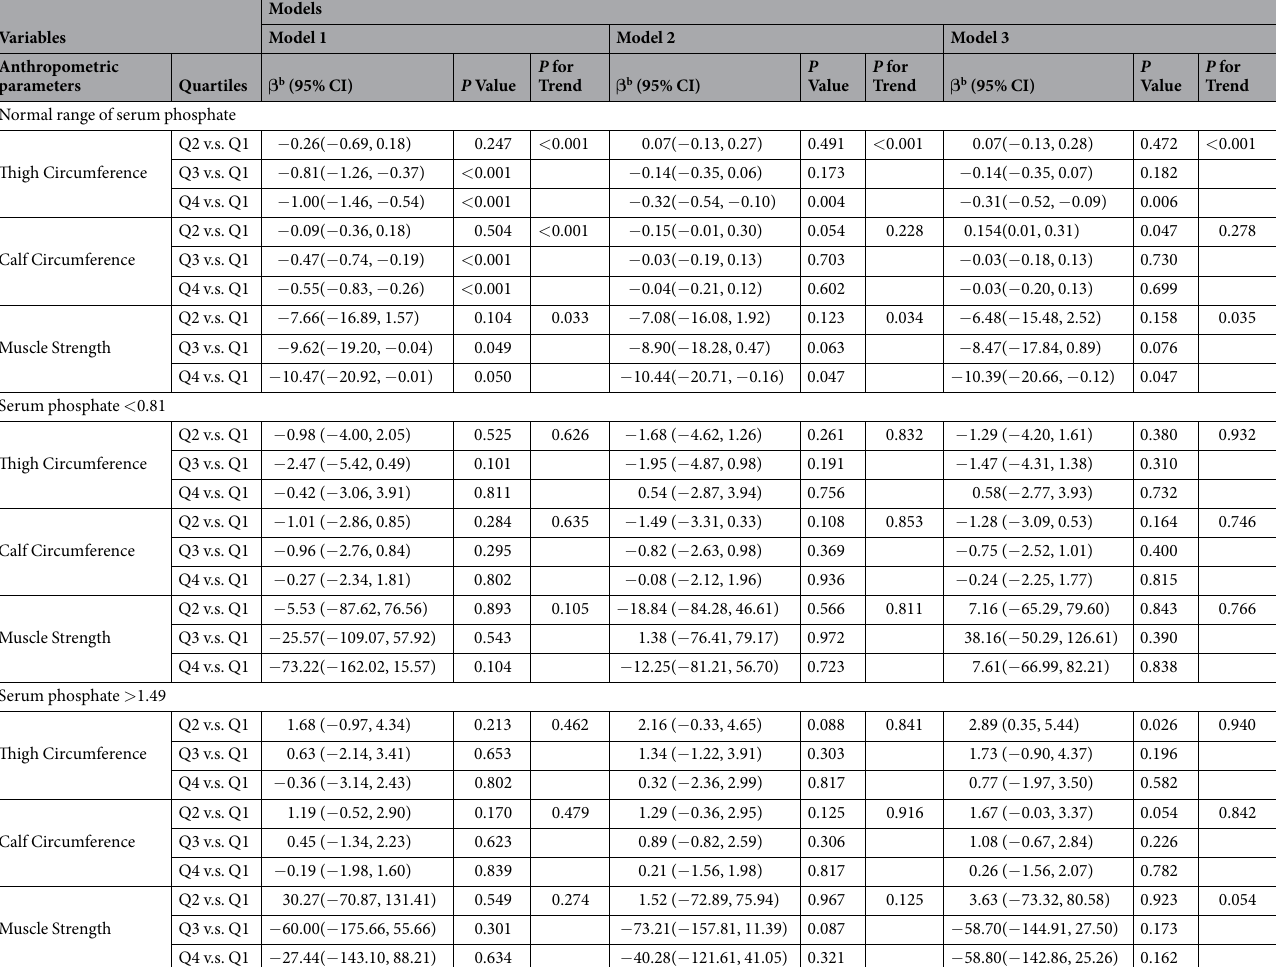
Table 3. Association between the Muscle strength and serum phosphate. a Adjusted covariates: Model 1 = Unadjusted. Model 2 = Model 1 + age, sex, race/ethnicity + BMI, serum fasting glucose, serum cholesterol, AST, serum HDL, serum calcium, serum creatinine. Model 3 = Model 2 + history of congestive heart failure, coronary heart disease, angina/angina pectoris, heart attack, stroke, smoking. b β coefficients was interpreted as change of telomere length for each increase in different anthropometric parameters. Abbreviation: BMI, body mass index; SBP, systolic blood pressure; ALT, alanine aminotransferase.